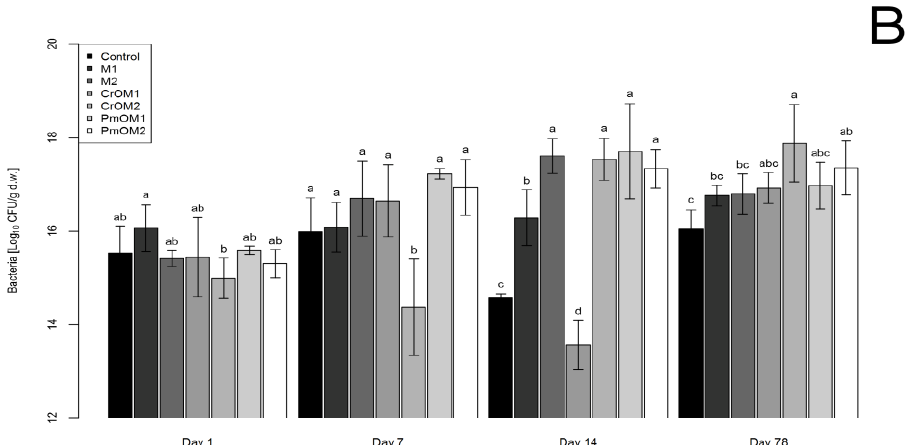
Figure 1. The abundance of bacteria in sandy ( A ) and loamy ( B ) soils depending on different treatments with maltodextrin (M1 and M2) and encapsulated essential oils of caraway (CrOM1 and CrOM2) and peppermint (PmOM1 and PmOM2). 1 and 2 refer to doses of microcapsules, 50 and 200 g per 1 kg of soil, respectively. Letters on error bars denote statistical significance among groups according to Duncan’s MLR post hoc test at level p < 0.05.